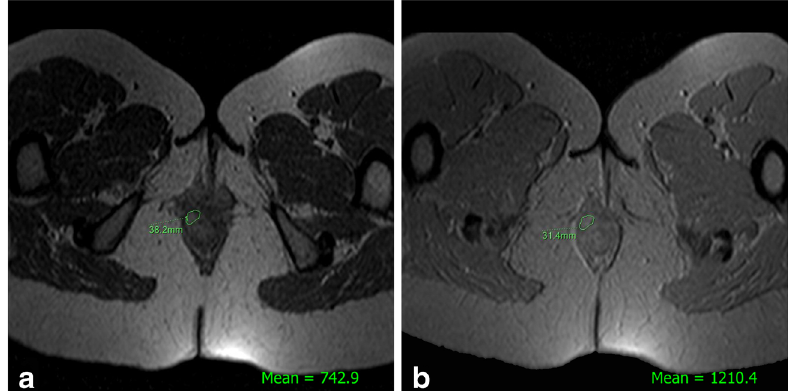
Fig. 12 Calculation of the magnetisation transfer ratio of a fistula. a Signal intensity on an oblique-transverse gradient-echo image encoded at 800 off- resonance radio frequency saturation. b Signal intensity on an oblique-transverse gradient- echo image without radio frequency saturation. The magnetisation transfer ratio (%) is = 1- (M sat image / M nonsat image) ×